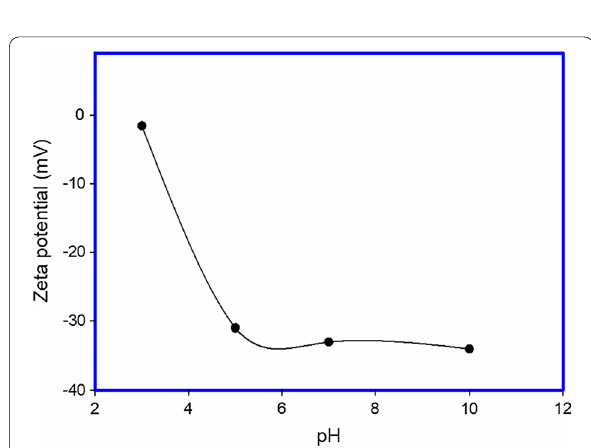
Fig. 6 Change of surface charge of sodium titanate nanotubes with pH